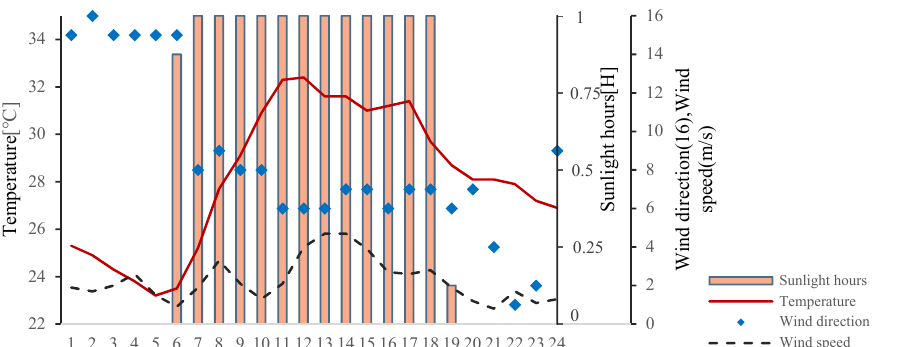
Figure 10. Meteorological characteristics of the case study day (5 August 2016). Includes sunlight hours, temperature, wind direction, and wind speed.